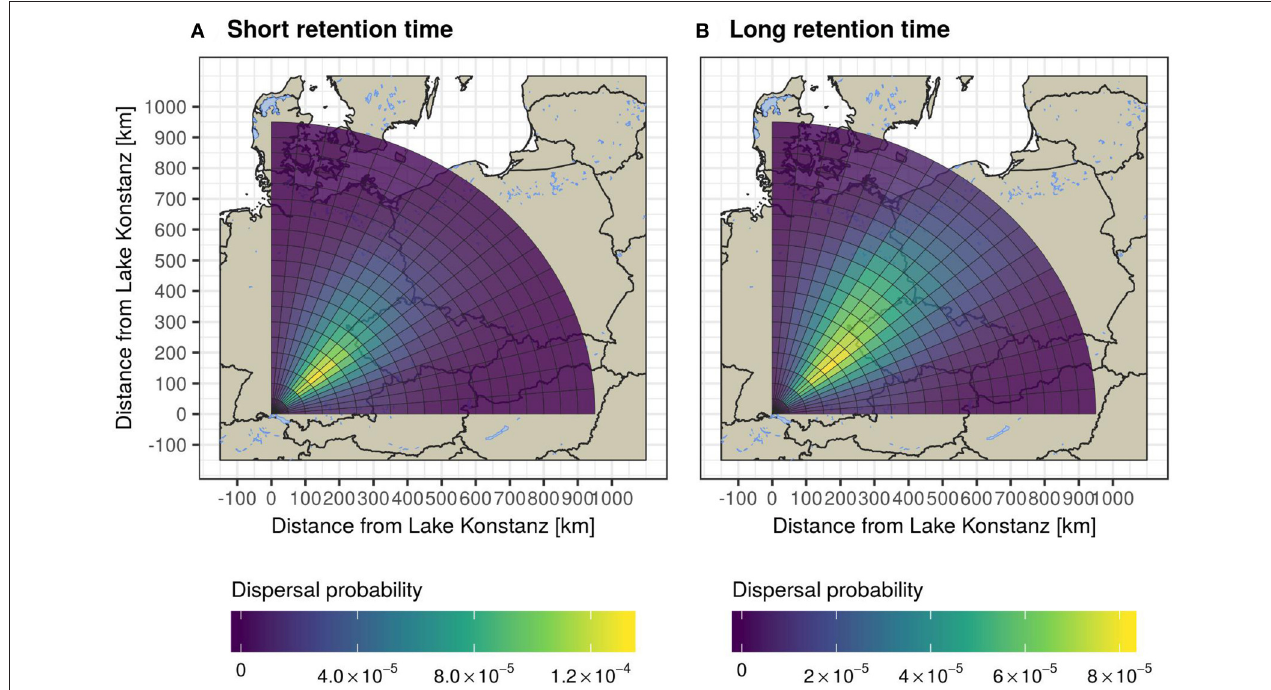
FIGURE 4 | Seed dispersal shadows for short (a) and long (b) retention time scenarios, resulting from endozoochorous dispersal of mallards on spring migration from the Lake Constance region. In this figure, mallards are assumed to ingest seeds just before departing on migration and to not use stopovers. Here, seed dispersal probability represents the product of excretion probability as suggested by gut retention curves and the proportion of simulated mallards passing through a given annulus section.